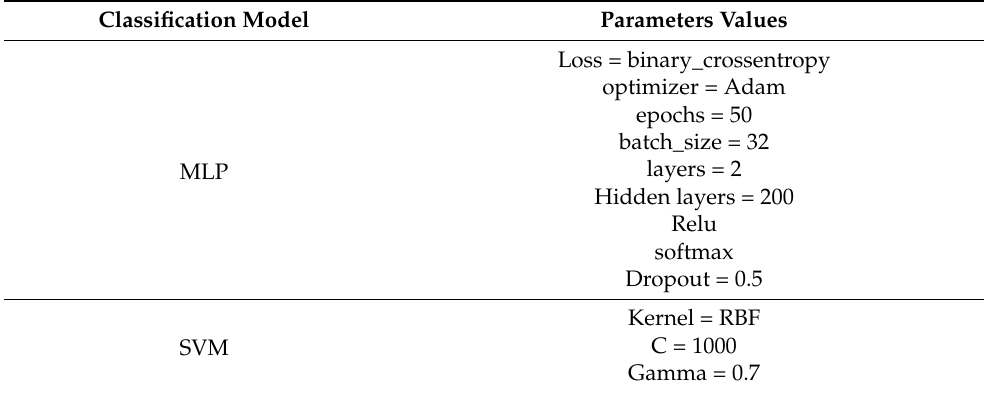
Table 3. Classification models parameter